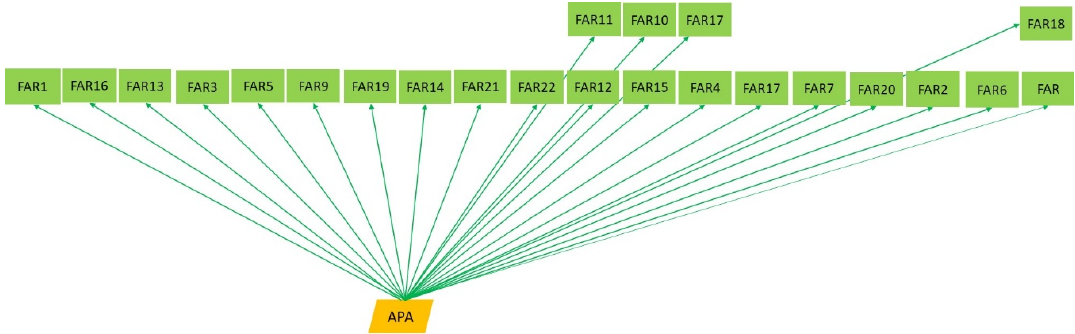
Figure 6. Food network detected in 2018: the technical assistance of the livestock association (APA) to the farms (FARn). Source: own data.